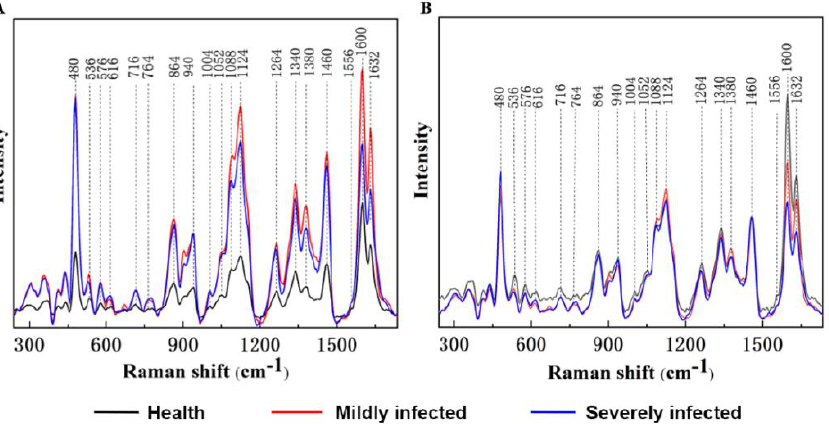
Figure 3. Raw Raman spectra ( A ) and Raman spectra normalized by the peak at 1460 cm − 1 ( B ) of healthy wheat kernels, mildly FHB − infected kernels, and severely FHB − infected kernels.